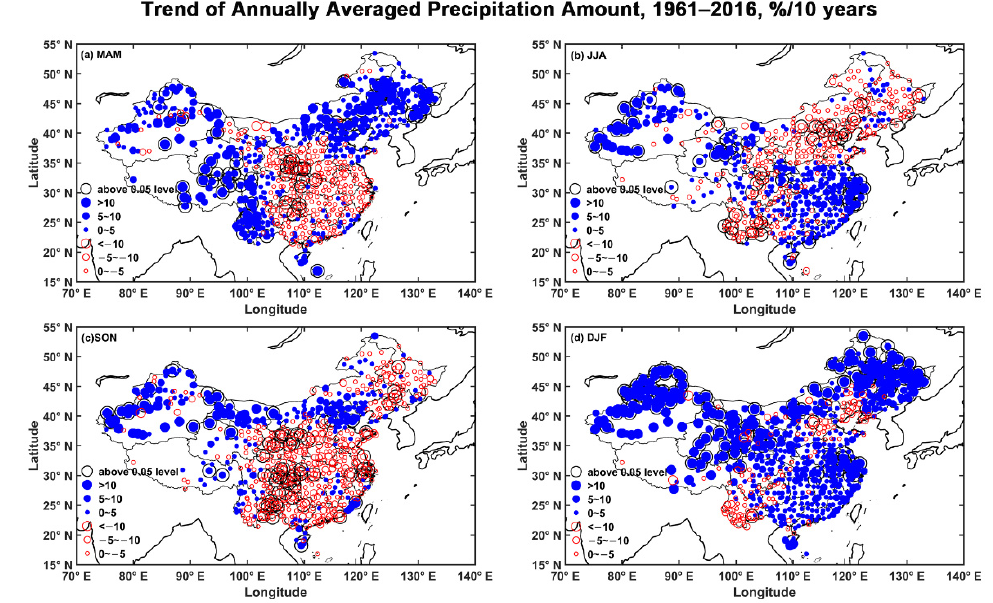
Figure 4. The decadal trends of relative changes of seasonally averaged precipitation amount (unit: % /10 years) in ( a ) spring (MAM), ( b ) summer (JJA), ( c ) autumn (SON), and ( d ) winter (DJF) at 635 ground stations.